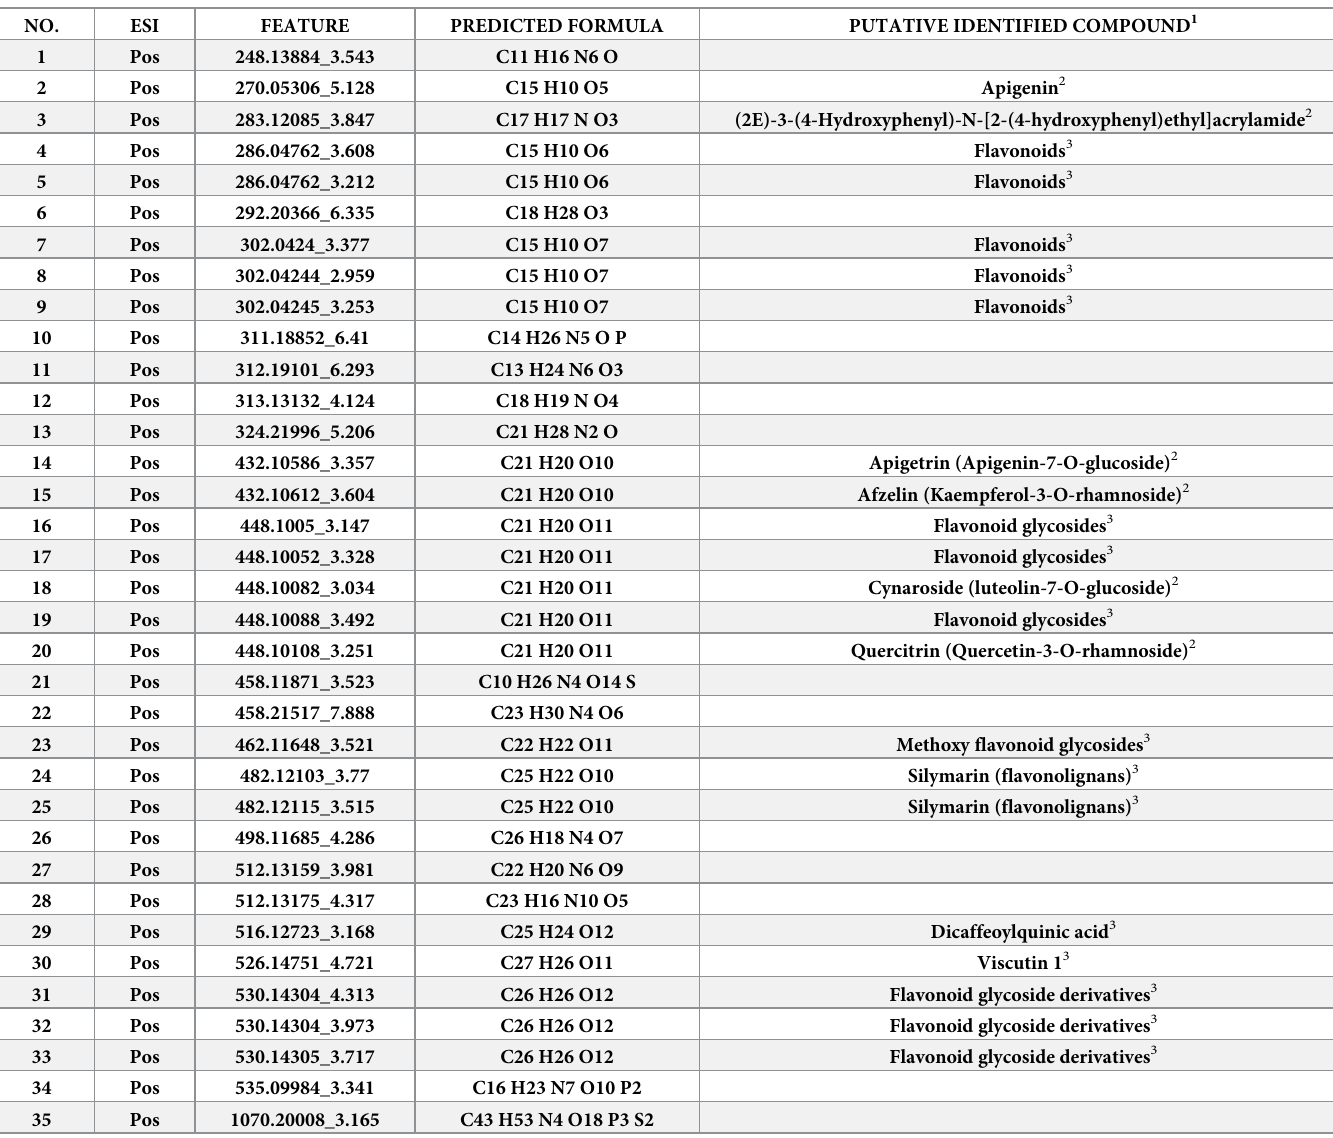
Table 3. Summary of metabolite features contributed to the discrimination between F3: EtOH/EtOAc and F5: EtOH/H 2 O fractions in ESI positive mode.